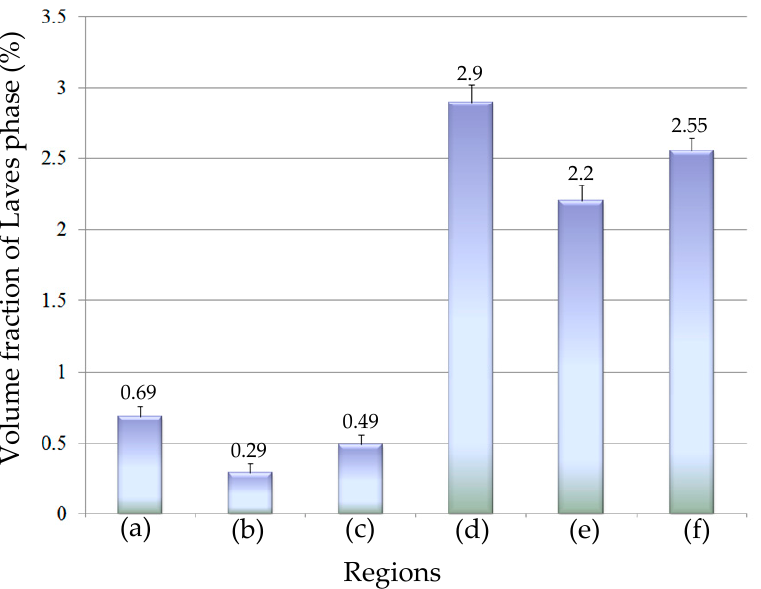
Figure 12. The average volume fraction of Laves phase (LPVF) ( a ) in equiaxed interdendritic regions of No.1 alloy; ( b ) in columnar interdendriticregions of No.1 alloy; ( c ) LPVF of No.1 alloy; ( d ) in equiaxed interdendritic regions of No.2 alloy; ( e ) in columnar interdendriticregions of No.2 alloy; ( f ) LPVF of No.2 alloy.